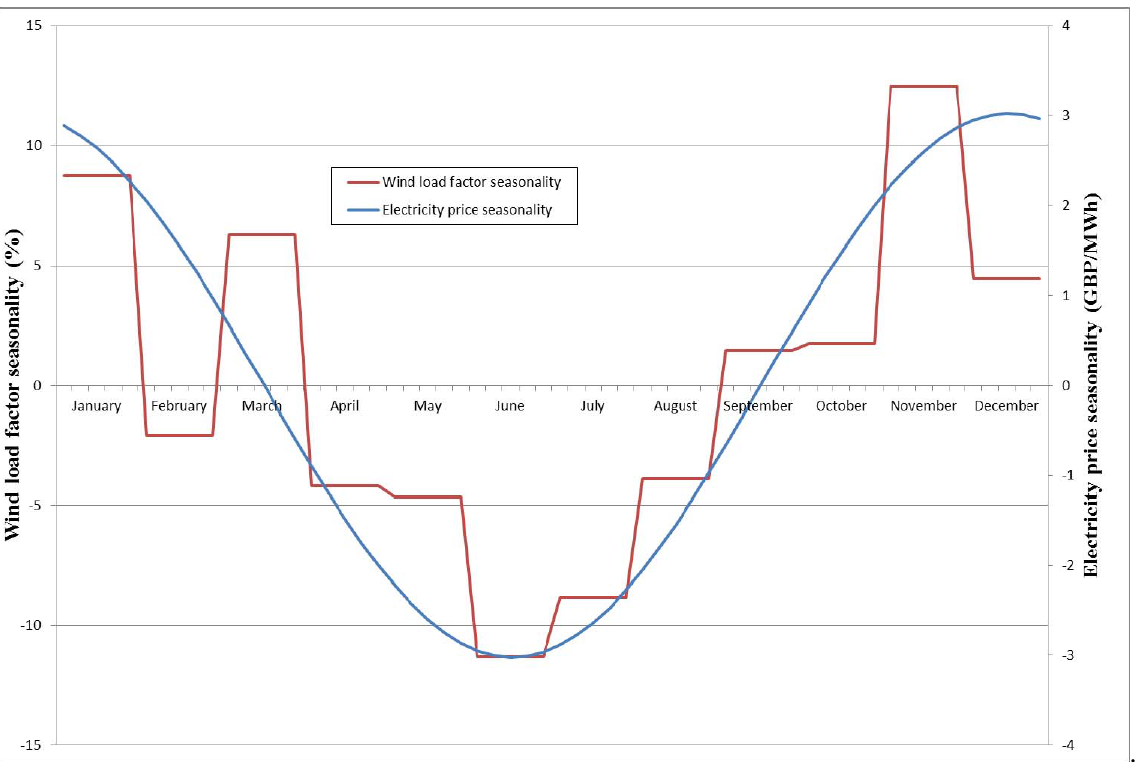
Figure 2. Monthly load factor of UK wind farms